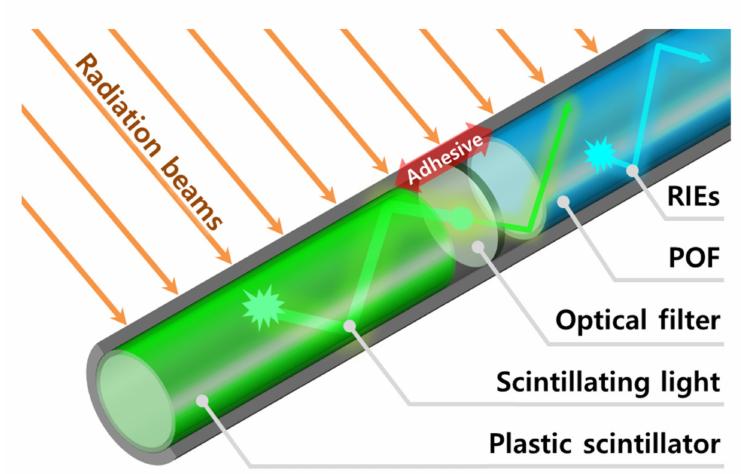
Figure 2. Structure of an optical filter-embedded